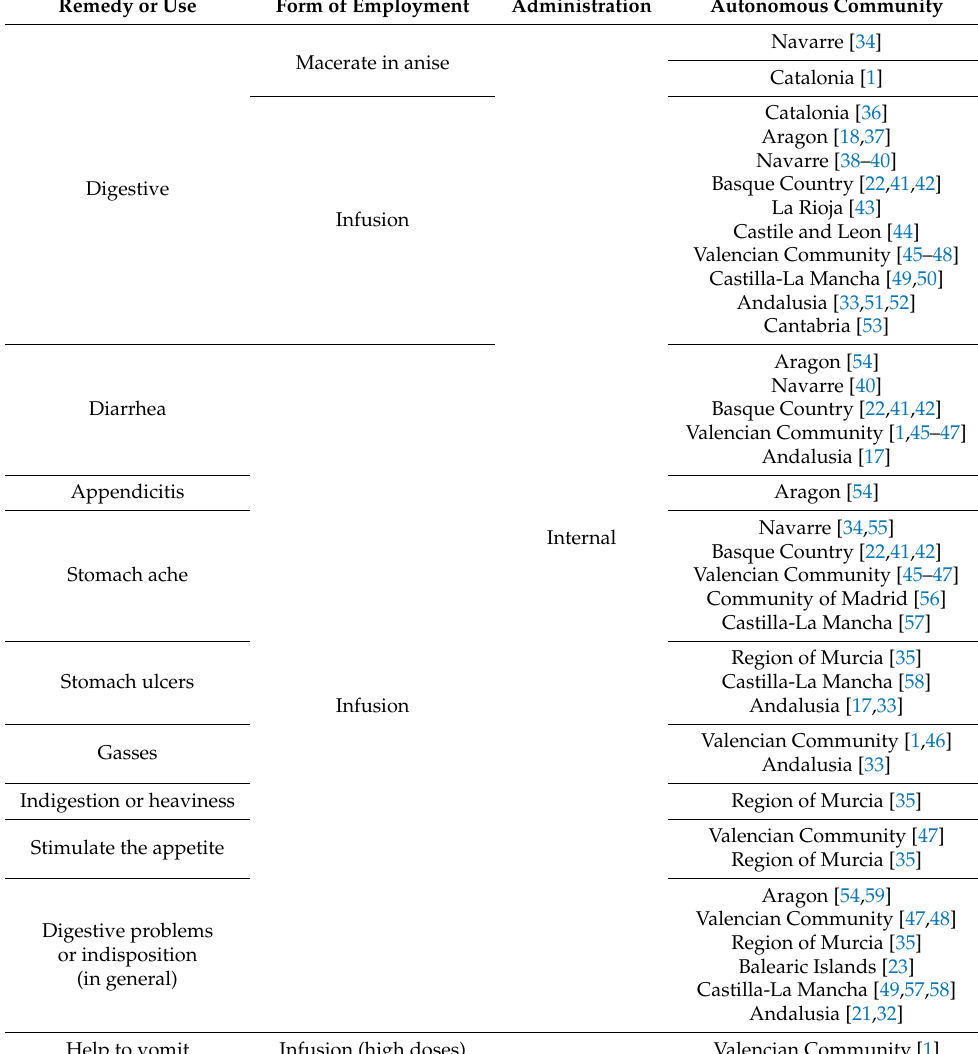
Table 2. Compilation of the medicinal uses of Chiliadenus glutinosus as a remedy for diseases of the digestive system in Spain, compiled from the existing specific literature.